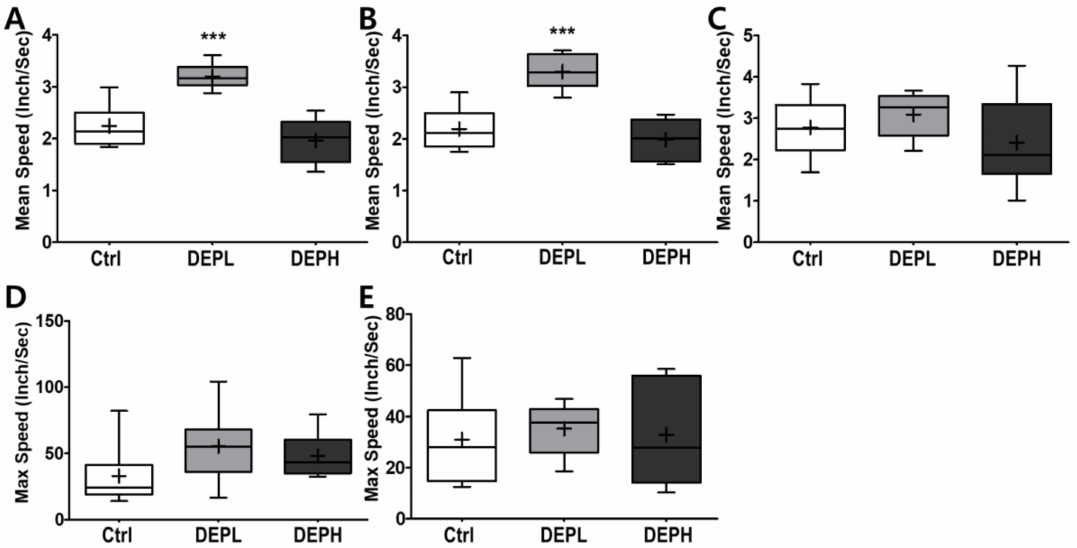
Figure 8. Box-and-whisker plots showing behavior changes in the open-field after diesel exhaust particles (DEP) exposure. ( A ) The total mean speed, ( B ) mean speed on the border, ( C ) mean speed in the center, ( D ) max speed on the border, and ( E ) max speed in the center area during the 10 min of the open field test; n = 8 for each group. The one-way ANOVA was followed by Tukey’s post-hoc test; *** p <